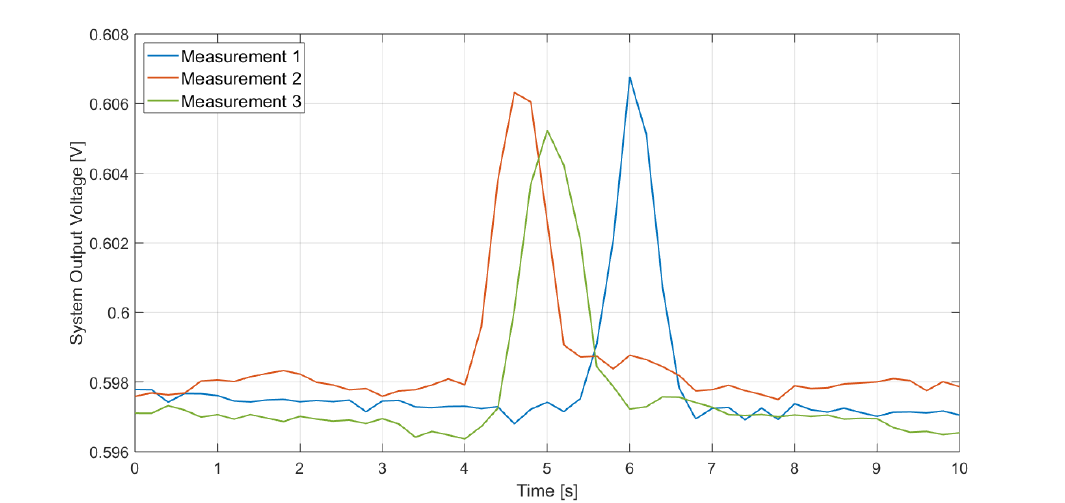
Figure 20. Measuremets results in the case of a subject walking at 1 m in front of the sensor. The sensor is located at a 132-cm height from the